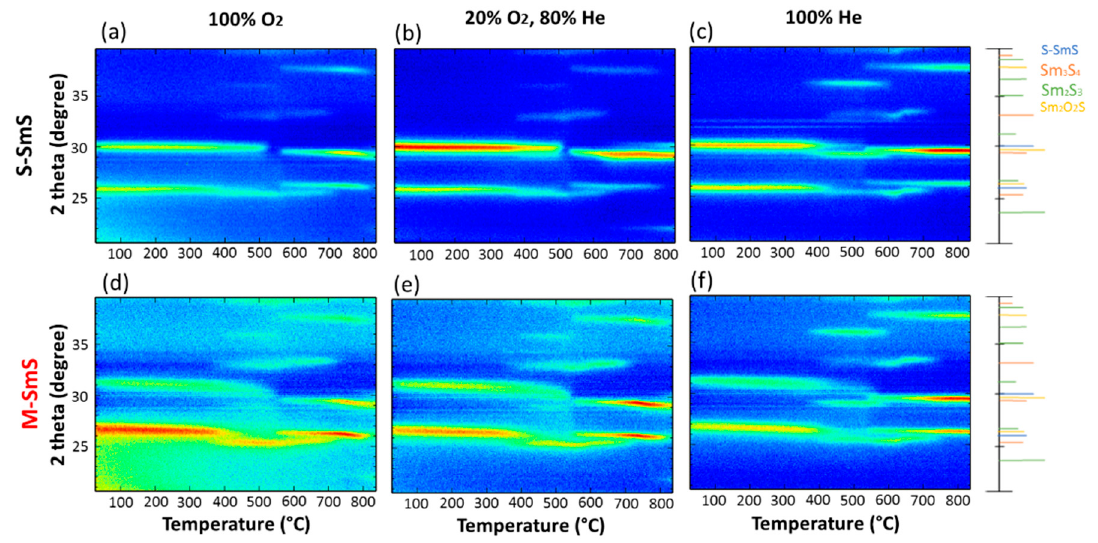
Figure 6. ( a ) In-situ XRD pattern of a 100 nm S-SmS on Si (100), under 100% O 2 . ( b ) Under 20% O 2 , 80% He. ( c ) Under 100% He. ( d–f ) Correspondingly for M-SmS. In all cases, the temperature ramp rate is 10 °C/s. The main peaks from the JCPDS (Joint Committee on Powder Diffraction Standards) files are indicated on the right.